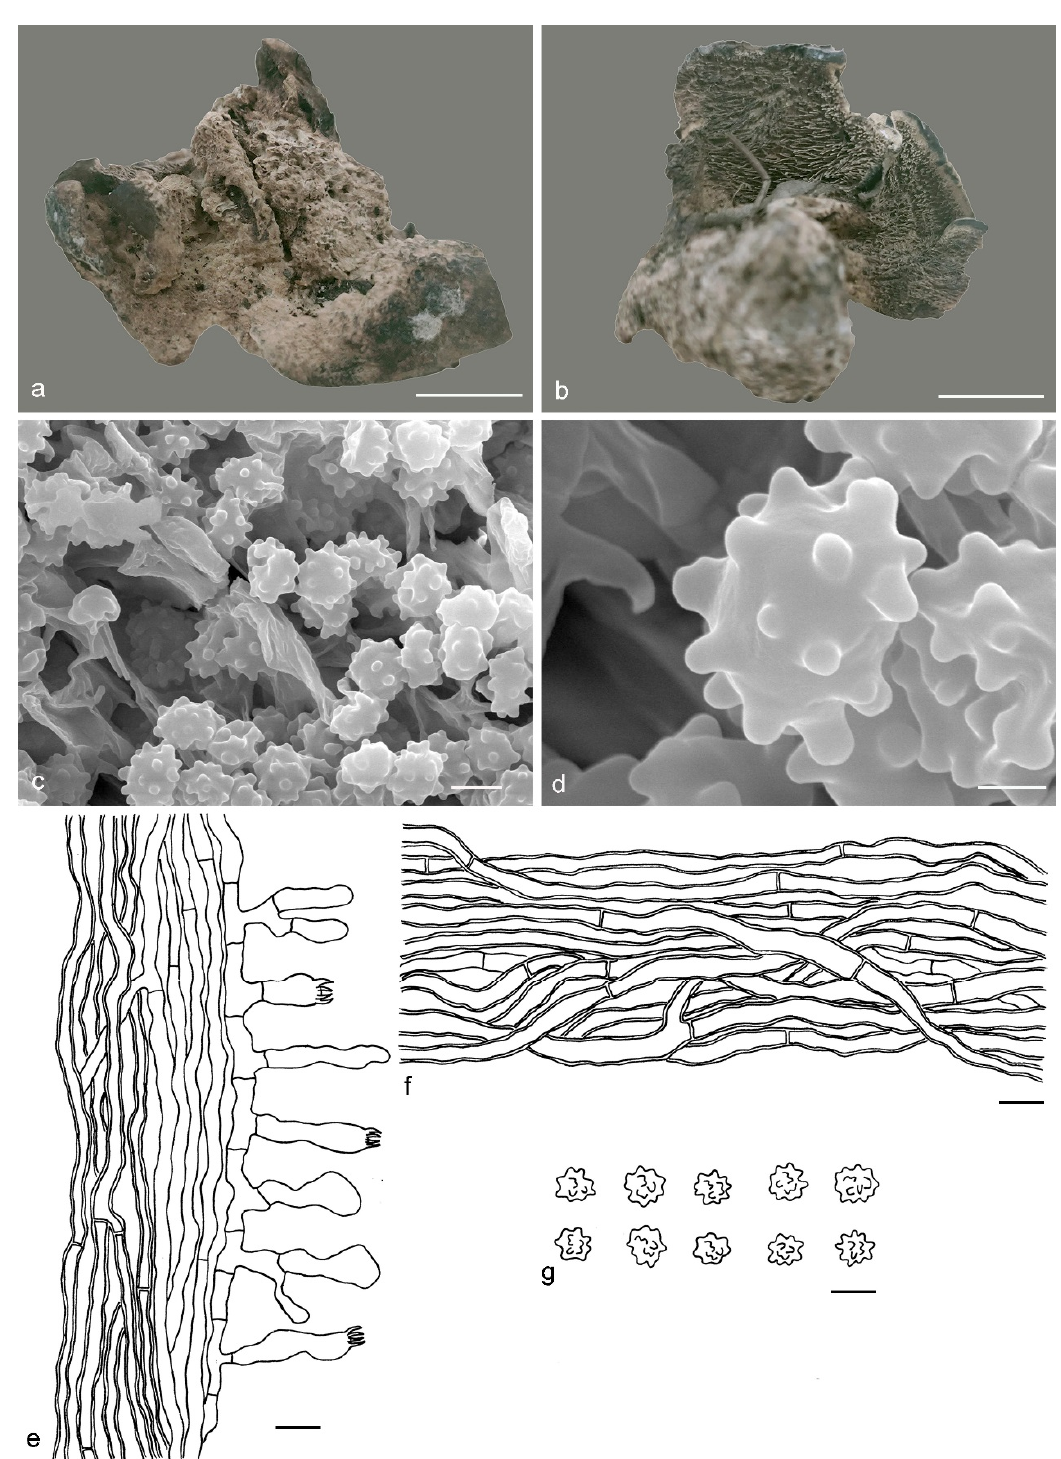
Figure 5. Hydnellum granulosum. ( a , b ): Basidiocarps; ( c , d ): SEM of basidiospores; ( e – g ): Microscopic structures (drawn from IFP 019400); ( e ): Section of hymenophore trama with basidia; ( f ): Hyphae from pileus context; ( g ): Basidiospores. —Scale bars: ( a , b ) = 1 cm; ( c ) = 3 μm; ( d ) = 1 μm; ( e , f ) = 10 μm; ( g ) = 5 μm.